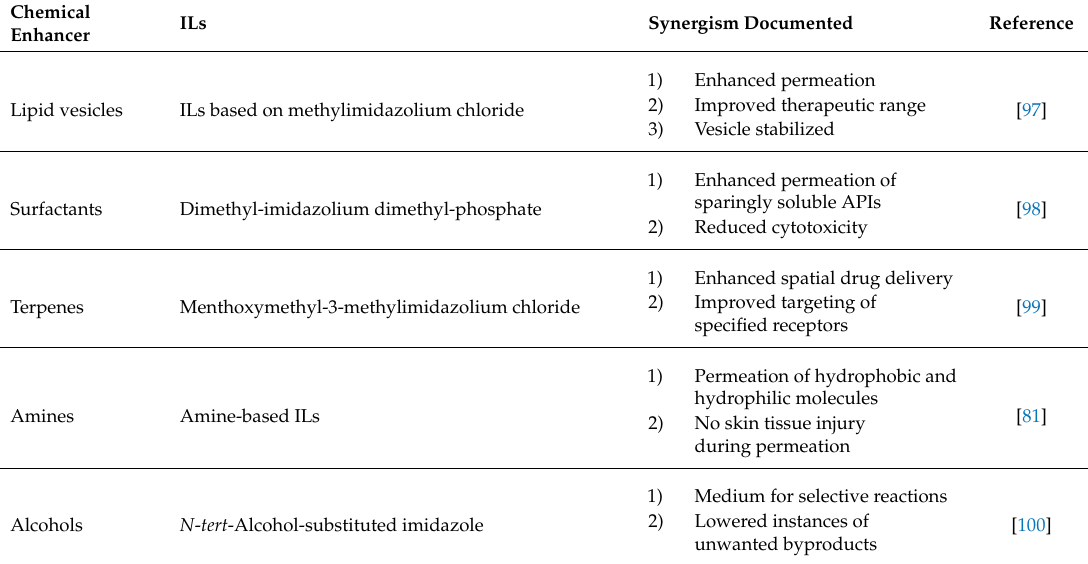
Table 3. Presented here are some of the applications of ILs synergistically used to enhance drug delivery with chemical permeation enhancers (CPEs). APIs—active pharmaceutical